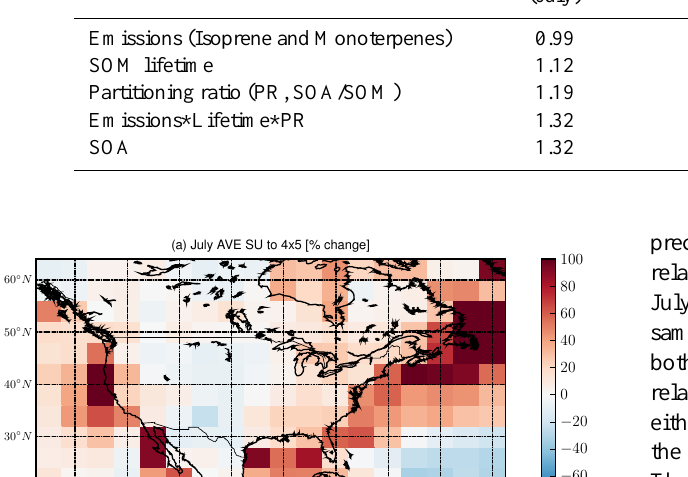
Emissions (Isoprene and Monoterpenes)